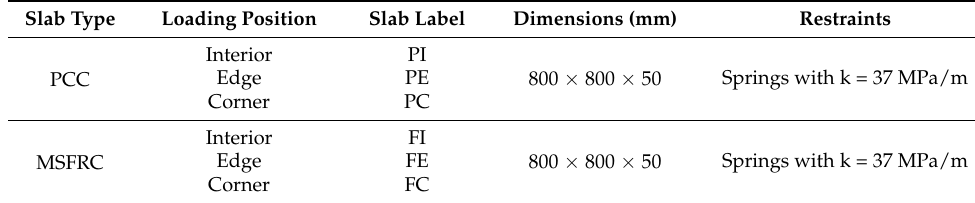
Table 5. Details of